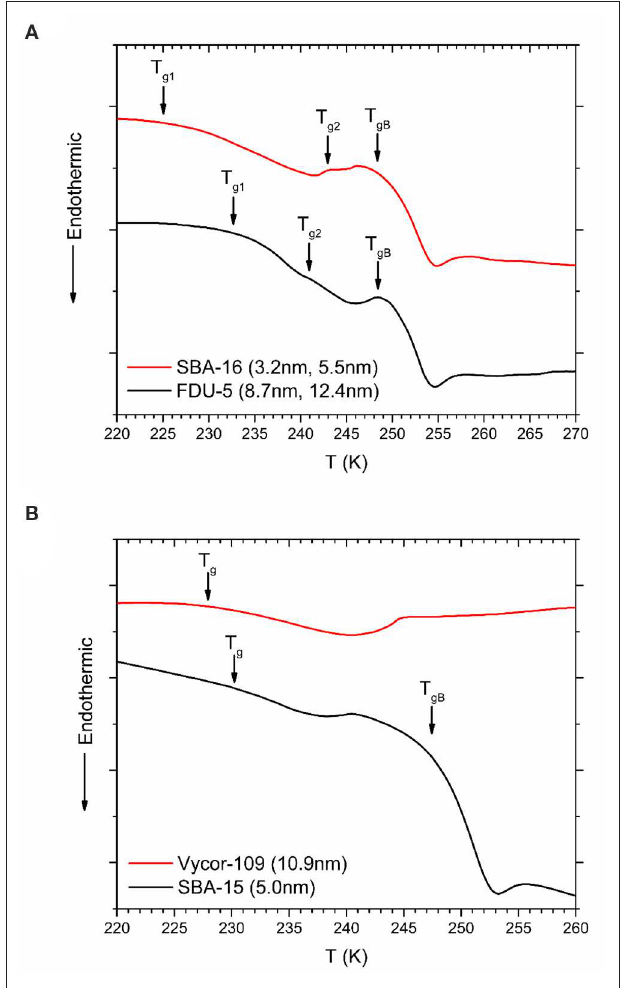
FIGURE 6 | DSC heating scans for OTP confined in (A) SBA-16 and FDU-5, (B) SBA-15, and Vycor-109. Scans for other vycor samples are not shown. T g corresponding to glass transition in nanopores and signals from bulk OTP (T gB ) are indicated by solid arrows.